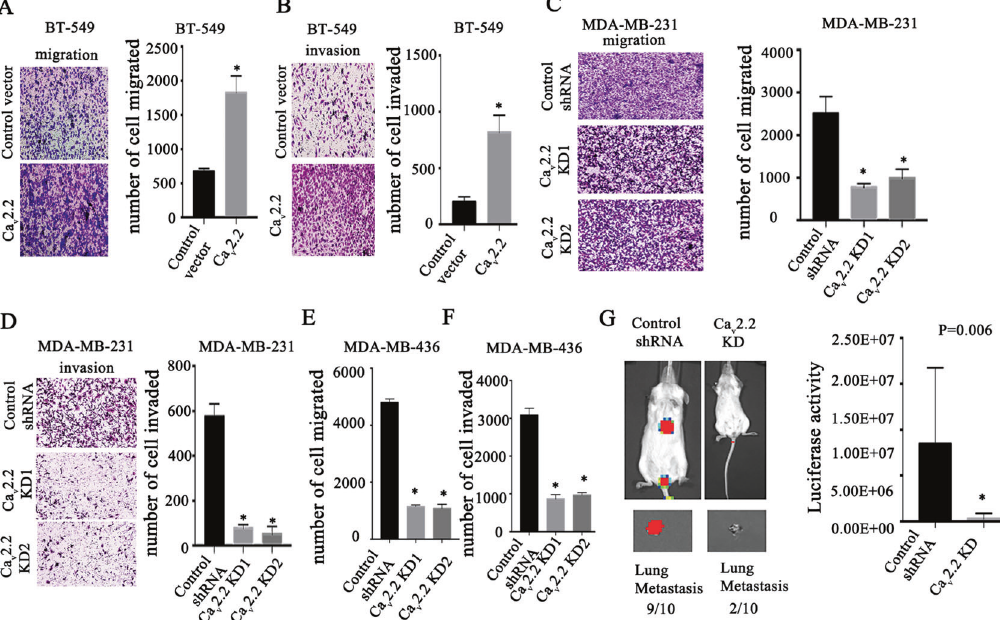
Fig. 2 Cav2.2 is required for migration, invasion and metastasis in breast cancer. Human breast cancer BT-549 cells transfected with Cav2.2 cDNA or a control vector were subjected to migration A and invasion B assays. Representative images of migrated or invaded cells were shown. The numbers of migrated and invaded cells were quanti fi ed. P value was determined using Student ’ s t-test (* p < 0.001). Error bars represent mean ± s.d. Human breast cancer MDA-MB-231 cells stably expressing Cav2.2 shRNA or control shRNA were subjected to migration C and invasion D assays. Representative images of migrated or invaded cells were shown. The numbers of migrated and invaded cells were quanti fi ed. P value was determined using Student ’ s t-test (* p < 0.001). Error bars represent mean ± sd. Human breast cancer MDA-MB-436 cells stably expressing Cav2.2 shRNA or control shRNA were subjected to migration E and invasion F assays. The numbers of migrated and invaded cells were quanti fi ed. P value was determined using Student ’ s t-test (* p < 0.001). Error bars represent mean ± sd. G Luciferase-tagged human breast cancer MDA-MB-436 cells stably expressing Cav2.2 shRNA or control shRNA were transplanted in mice. Metastasis were imaged using Xenogen bioluminescence system. P value was determined using Fisher ’ s exact test ( p = 0.006).